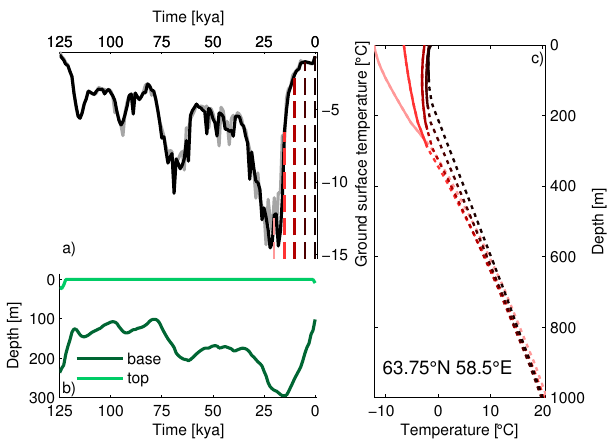
Figure 13. Same as Fig. 12 but for west Siberia. In (b) the evolution of the depth of the top (light green) of the permafrost layer is also shown.